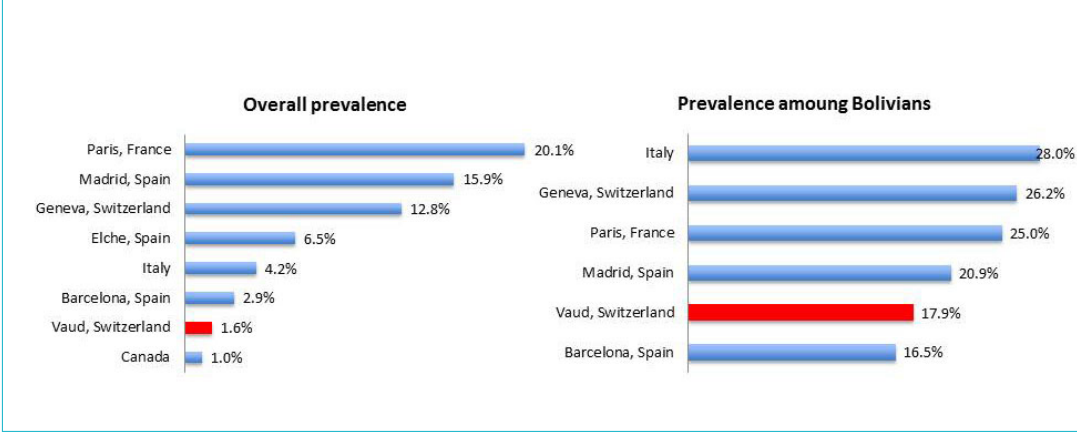
Figure 3: Prevalence of Chagas disease found in several studies in non-endemic countries. Studies from Paris, France (21), Madrid, Spain (19), Geneva, Switzerland (10), Italy (20), Elche, Spain (18), Barcelona, Spain (14-16) and Canada (22). Migrants include people born in Latin America or born from a Latin American mother.